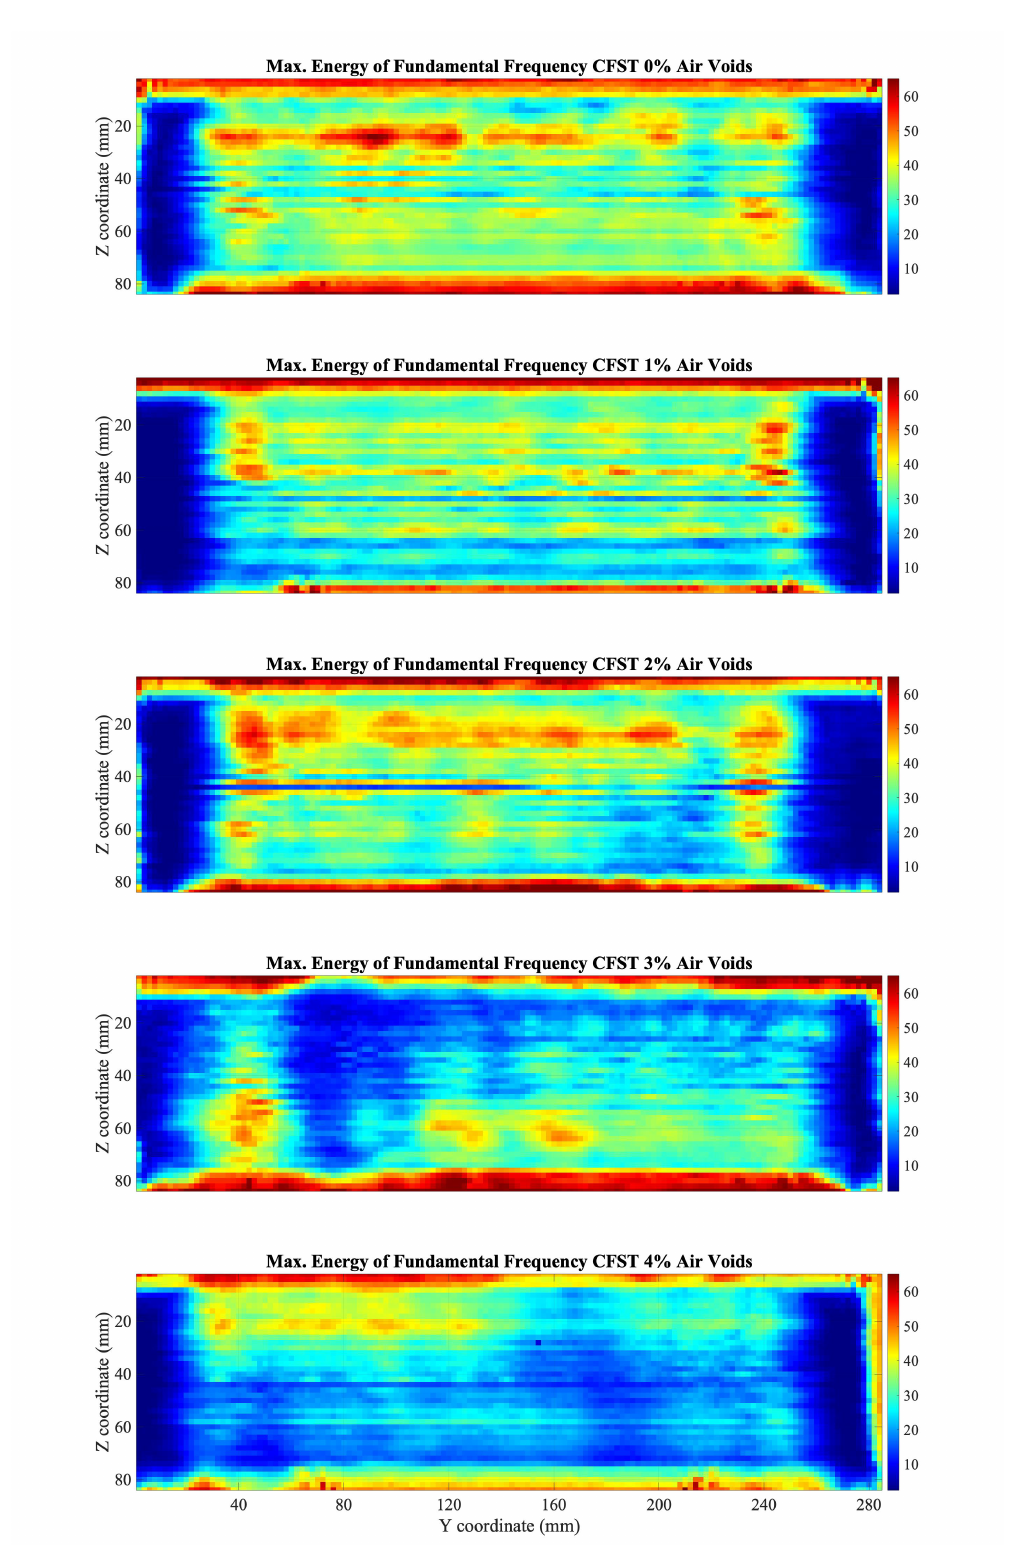
Figure 8. C-Scan of the fundamental harmonic amplitudes using STFT for the five CFST